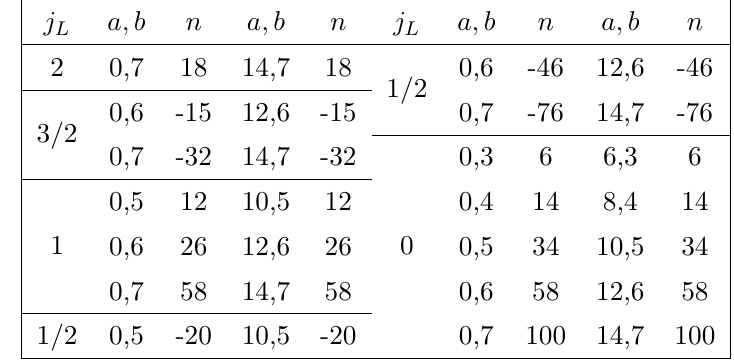
Table 1 . GV invariants n j L